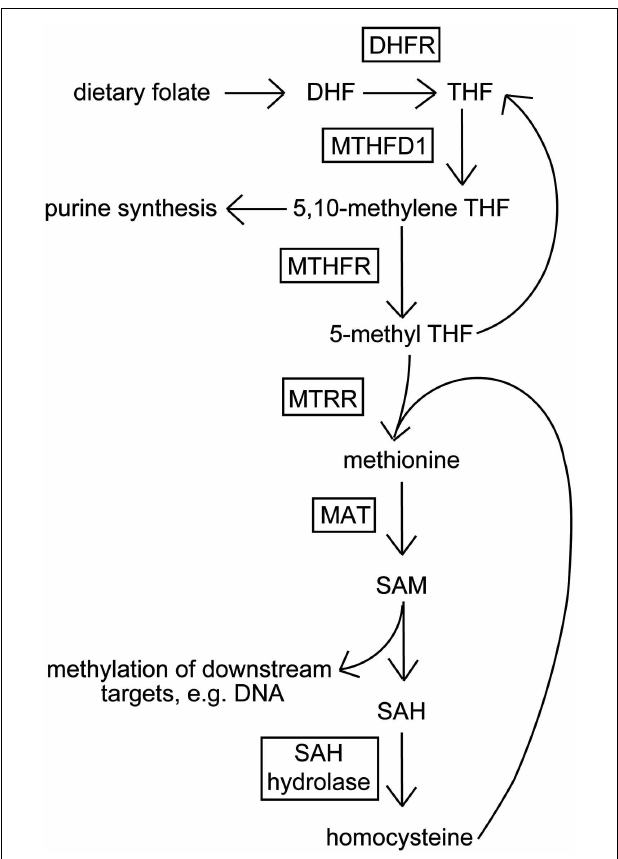
FIGURE 1 | Schematic of the folic acid metabolic cycle. Dietary folate (vitamin B12) is converted to dihydrofolate (DHF), and subsequently metabolized to tetrahydrofolate (THF) by dihydrofolate reductase (DHFR). THF is converted to 5,10-methyleneTHF by methylenetetrahydrofolate dehydrogenase 1 (MTHFD1), then to 5-methylTHF by methylene tetrahydrofolate reductase (MTHFR). 5-methylTHF is demethylated and combined with homocysteine to form methionine by 5-methyltetrahydrofolate-homocysteine methyltransferase reductase (MTRR). Methionine is transformed to S-adenosyl methionine (SAM) by methionine S-adenosyltransferase (MAT). SAM-dependent methyltransferases metabolize SAM into S-adenysyl homocysteine (SAH) methylating downstream targets. SAH is converted to homocysteine by SAH